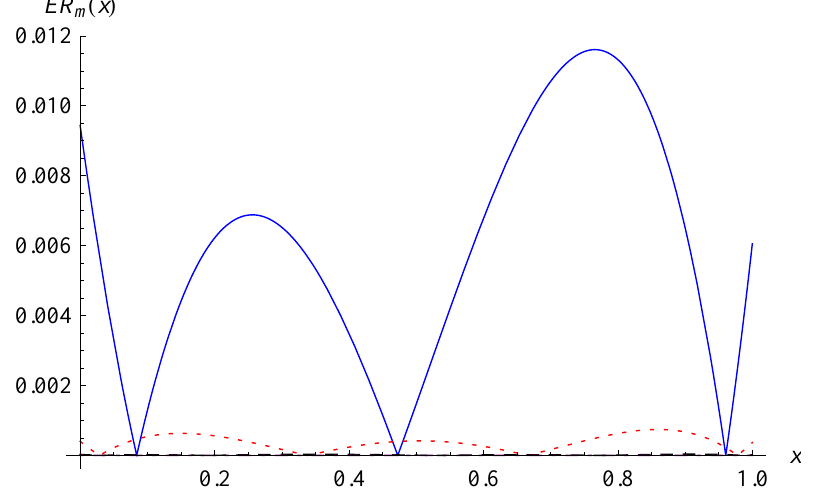
Figure 4. For λ = 2, the error functions ER m ( x ) for m = 2 (solid line), m = 3 (dot line), m = 4 (dash line) and m = 5 (dot-dash